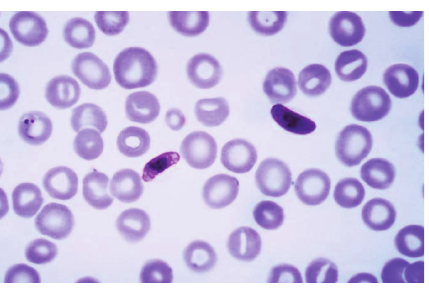
Figure 1: Blood peripheral smear showing crescentic shaped game-